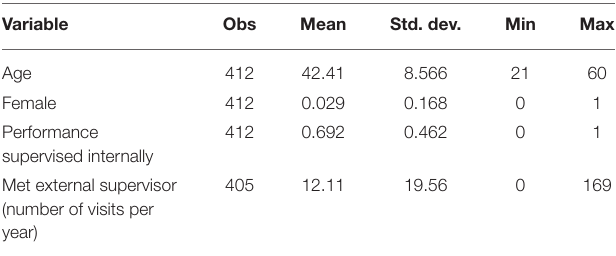
TABLE 4 | Descriptive Analysis of the variables used in the model.